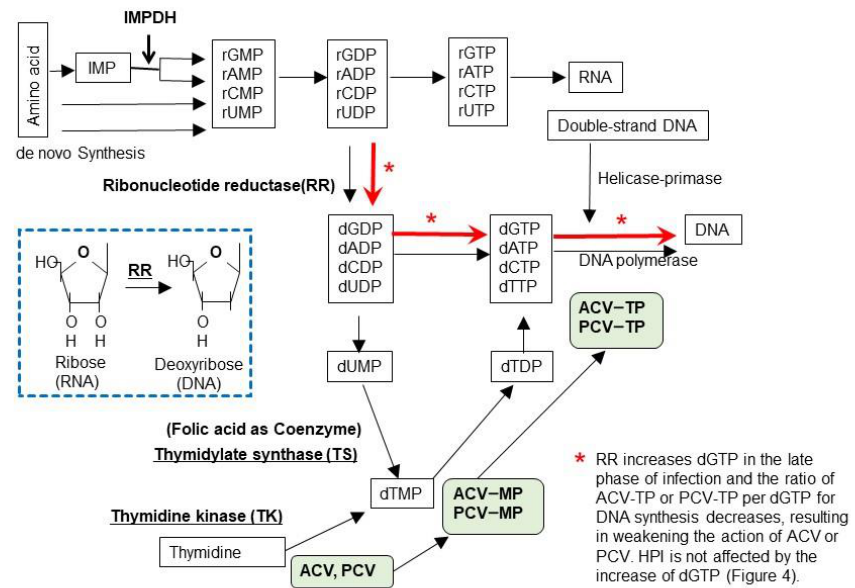
Figure 3. Biosynthesis of nucleotides. Purines and pyrimidines are synthesized de novo from amino acids as the ribose form of nucleotides and inosine monophosphate (IMP) that are modified by IMP dehydrogenase to adenosine-monophosphate (rAMP) and guanosine-monophosphate (rGMP). Next, nucleotide monophosphate (rNMP) is phosphorylated to a triphosphate form (rNTP), which is the substrate for RNA. The ribose form of nucleotide diphosphate (rNDP) is converted to the 2’-deoxyribose form (dNDP) by cellular or viral ribonucleotide reductase (RR), as shown in the lower box. When viral RR is induced by HSV and VZV infection, dNDPs are synthesized in the early phase of infection and are used for viral DNA synthesis, even in cells that do not actively synthesize cellular DNA. Thymidine is an important substrate of DNA and is supplied in two ways—by the conversion of uridine monophosphate (UMP) to thymidine monophosphate (TMP) via thymidylate synthase (TS) (de novo pathway) and from the systemic circulation by thymidine kinase (TK) (salvage pathway). Acyclovir (ACV) and penciclovir (PCV) are phosphorylated by viral TK and are further phosphorylated to the triphosphate form by cellular enzymes, as shown in the green-shaded boxes. ACV-TP and PCV-TP are incorporated into viral DNA by viral DNA polymerase, which results in chain termination. Foscarnet (PFA) and amenamevir (ASP2151) directly inhibit viral DNA synthesis by inhibiting DNA polymerase and HP, respectively. Nucleotides are used for RNA synthesis in the early phase of viral replication. ACV and PCV are efficiently phosphorylated by viral TK and inhibit viral DNA synthesis because the supply of dGTP is limited in infected cells. This efficient inhibition of viral replication by ACV continues for 5 h after infection. In the late phase of viral replication, ribonucleotides are converted to deoxyribonucleotides by viral RR for viral DNA synthesis as indicated by red arrows. Accordingly, large amounts of dGTP are supplied for DNA synthesis (approximately 60,000 and 90,000 dGTPs per DNA molecule of VZV and HSV, respectively) and this attenuates the inhibition of viral DNA synthesis by reducing the ratio of ACV-TP:dGTP. PFA and ASP2151 directly inhibit viral DNA synthesis and are not influenced by the supply of dGTP, which results in the efficient inhibition of viral growth in contrast to